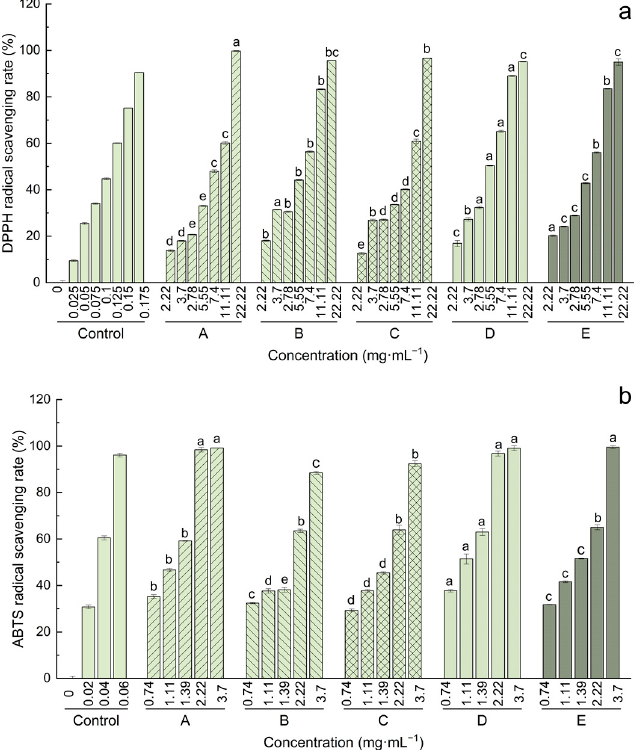
Figure 3. DPPH ( a ) and ABTS ( b ) free radical scavenging abilities of methanolic extracts of kiwifruit at different stages. Different letters (a–e) at the same concentration indicate significant differences in antioxidant potentials of samples during di ff erent post-softening stages .